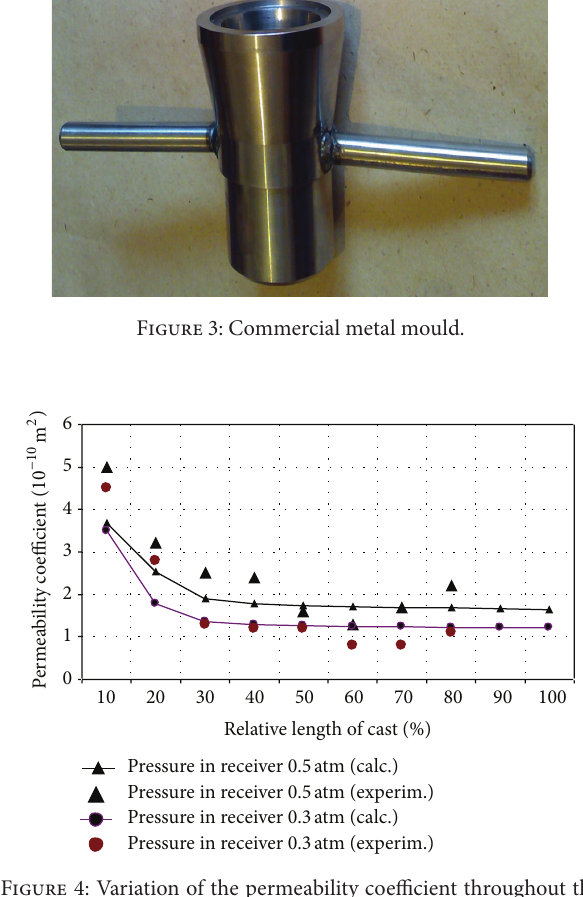
Figure 4: Variation of the permeability coefficient throughout the height of a cast with NaCl fraction of 0.315–0.63 mm.